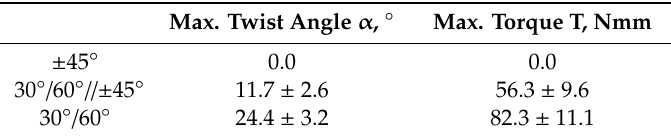
Table 2. Results for GF-PDMS composite with glass fiber textile and 45 mm gauge length for di ff erent fiber